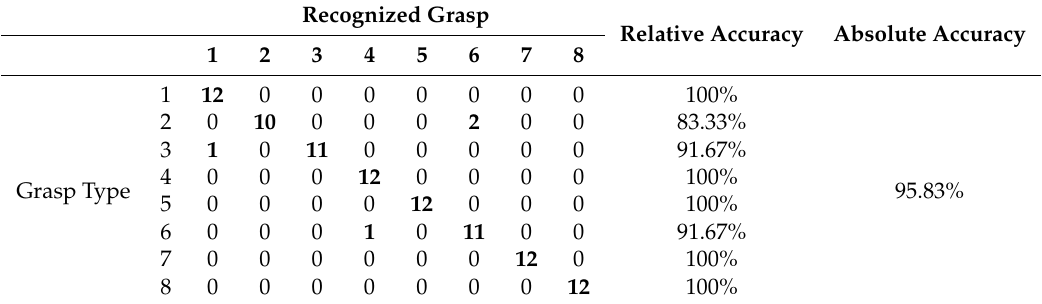
Table 3. Results: Volunteer 3.